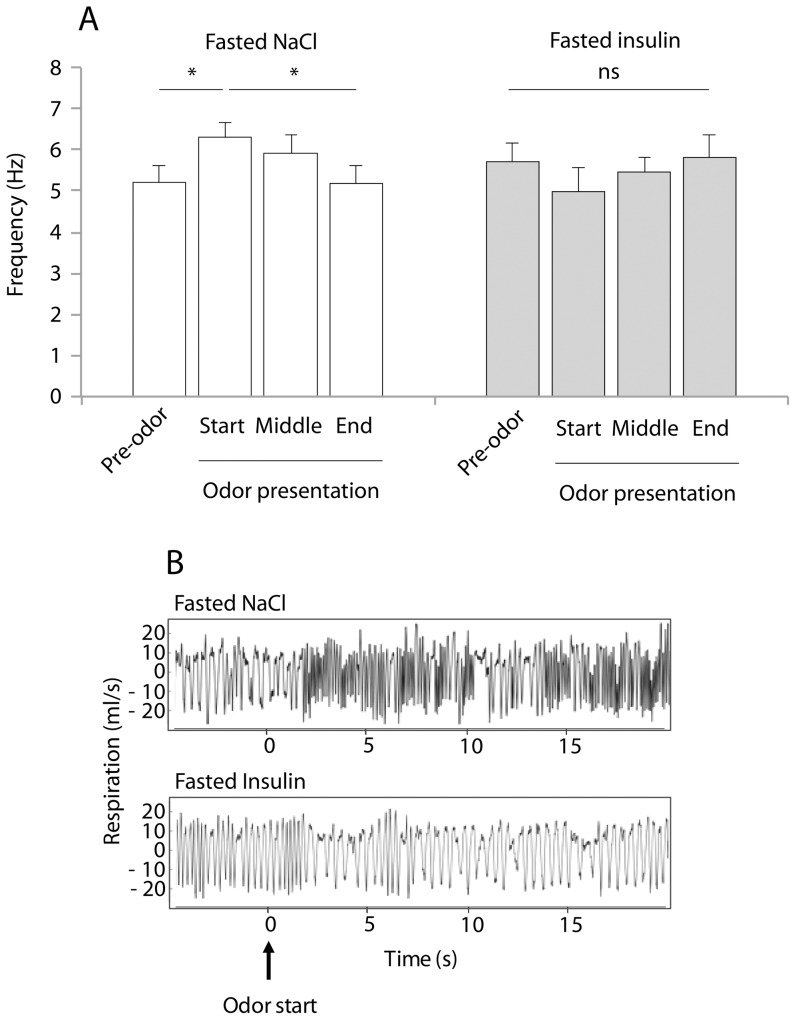
Insulin ICV injection (14 mU) alters olfactory sniffing behavior for a food-odor.
(A) Bar graphs represent evolution of the mean (± SEM) respiratory frequency during food odor presentation (30 sec), in fasted animals treated with NaCl (n = 10) or insulin (n = 10). Four periods of 10 seconds have been defined: Pre-odor (−10 sec to 0 sec); Odor presentation (start: 0 sec to 10 sec, middle: 10 sec to 20 sec, end: 20 sec to 30 sec). The mean of respiratory frequency of fasted-NaCl animals increased during the presentation of a food odor (Odor presentation, start) compared to Pre-odor period. In Fasted-Insulin rats, no change in respiratory frequency was observed upon odor presentation (Two-way repeated measures ANOVA followed by post-hoc comparisons; * p<0.05 significant differences). (B) Individual example of typical time-course of respiration frequency during food odor presentation in two conditions (Fasted rat treated with NaCl or insulin).